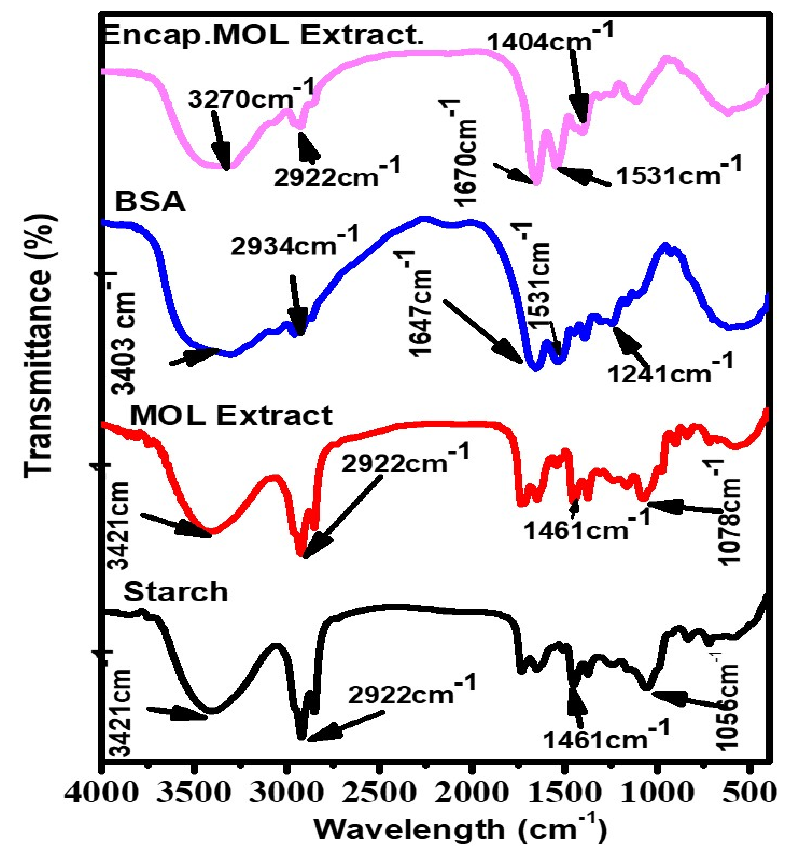
Figure 4. FTIR spectra of starch, MOLE,BSA and Encap. MOLE.